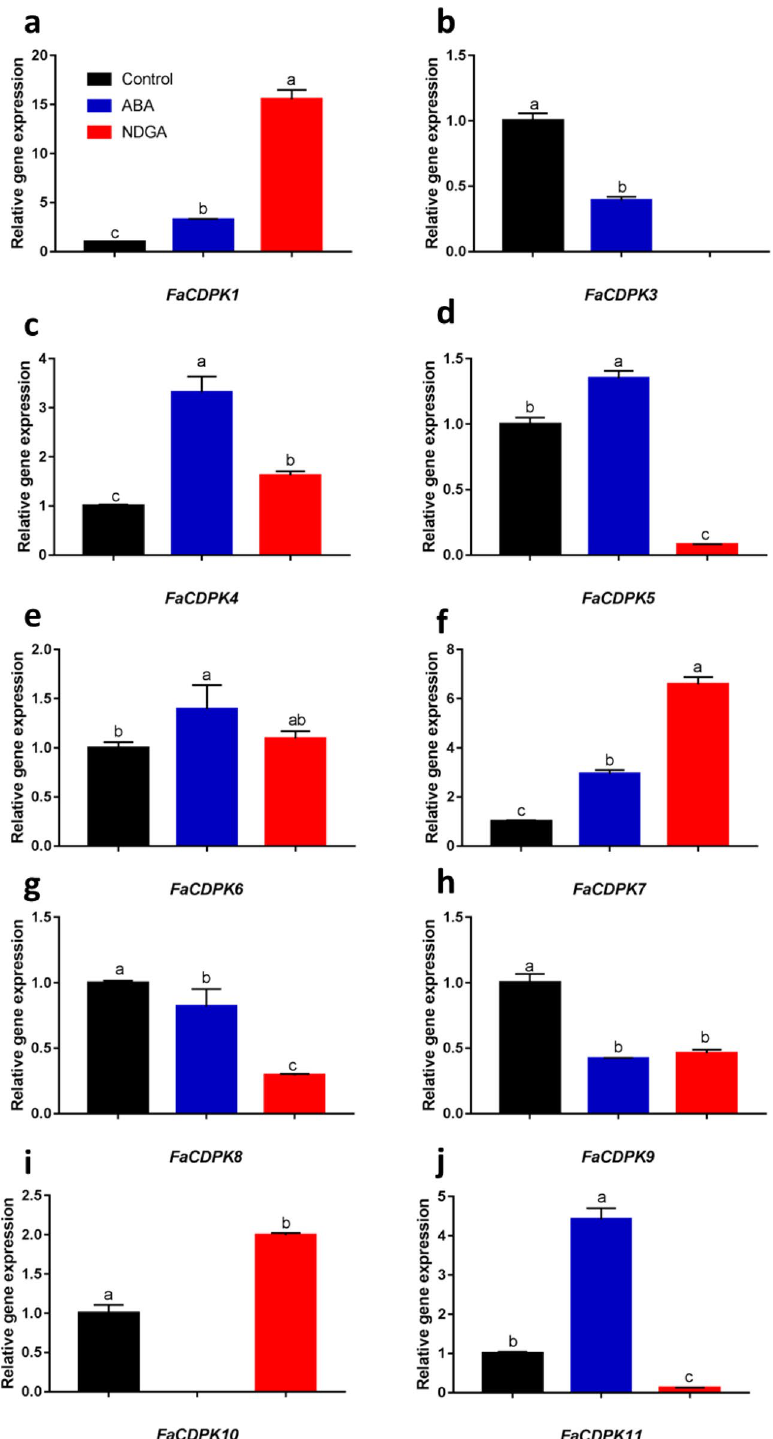
Figure 6. Expression of calcium-dependent protein kinases (CDPK) under abscisic acid (ABA) and nordihydroguaiaretic acid (NDGA) treatment in Fragaria × ananassa . The expression level of PIRUV_ DESCARB, DBP and HISTH4 was used as reference gene to normalize each reaction. The data was from four biological and three technical replicates. Data were subjected to one-way ANOVA test and when significant (p ≤ 0.05) were submitted to a comparison of means by Tukey test at 5% of probability. Different letters indicate significant differences between